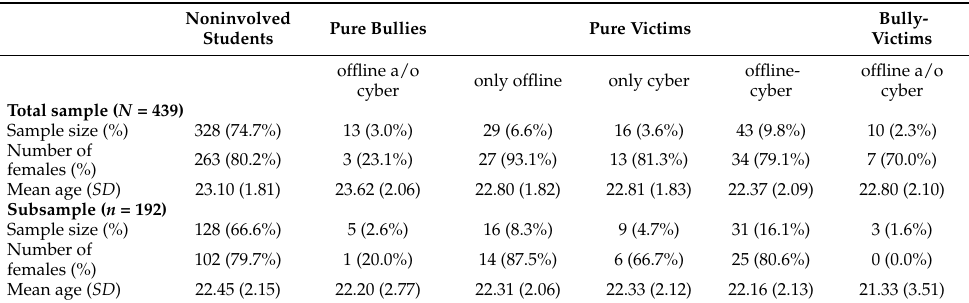
Table 3. Prevalence and Demographic Information of the Bullying-Related